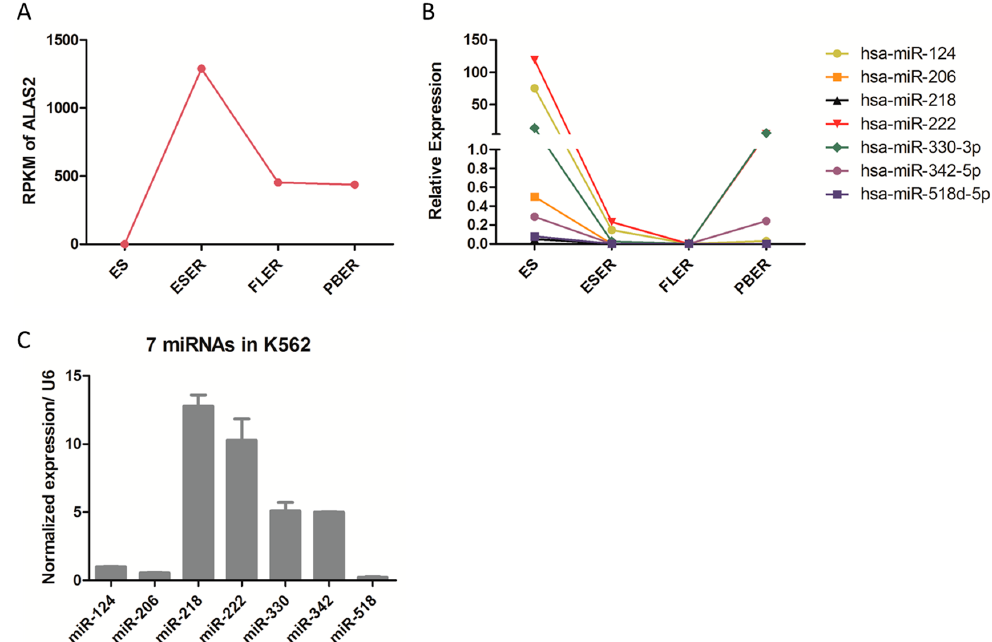
Figure 2. ( A ) RPKM (reads per kilobase of exon model per million mapped reads) value of ALAS2 in cells at different erythroid differentiation and development stages. The data was obtained from our previous study; ( B ) The CF (cloning frequency) value of seven miRNAs in cells at different erythroid differentiation and development stages. The data was obtained from our unpublished study; ( C ) Relative expression of seven miRNAs in K562 cells examined by quantitative real-time PCR normalized to snRNA U6 .